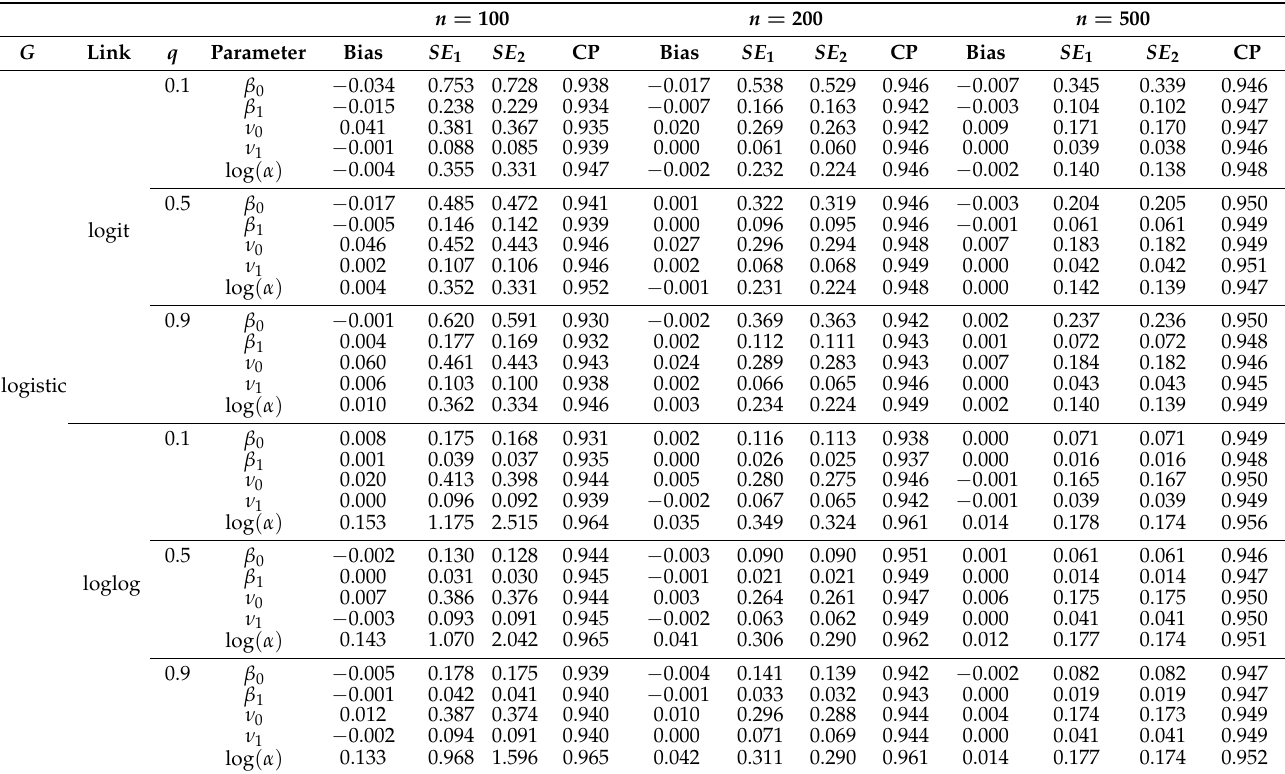
Table 2. Estimated bias, standard error of the estimated parameters ( SE 1 ), the mean of the estimated standard errors ( SE 2 ), and 95% coverage probabilities (CP), when G and the link are correctly specified (case G is the cdf of the logistic distribution).